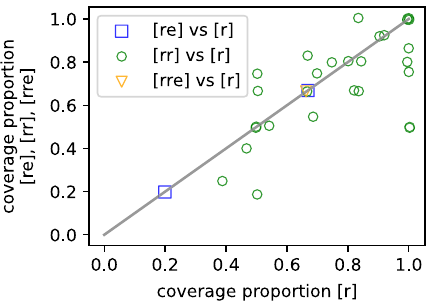
Fig. 7 Evaluation of the impact on the coverage of constructing the PKN with rules and/or events. The points are jittered with a Gaussian noise of variance 0.01 on both axes to ensure readability